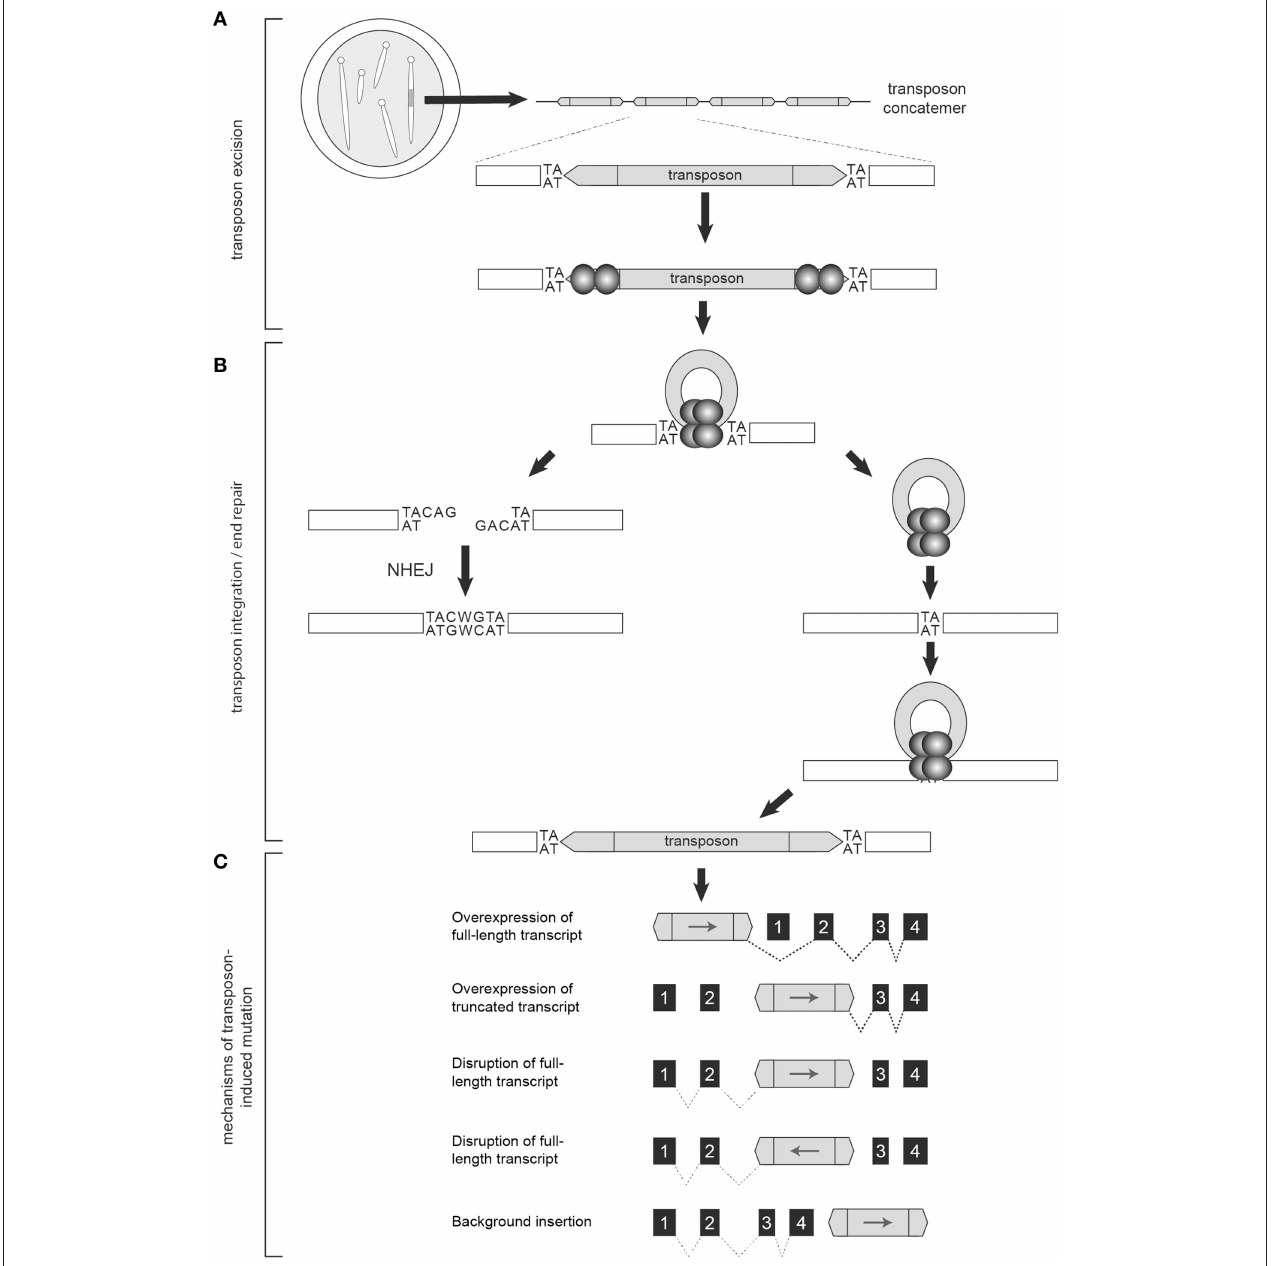
FIGURE 2 | The Sleeping Beauty System is designed to disrupt gene expression. Transgenic mice used in forward genetic SB screens harbor a transposon concatemer in one of their chromosomes (A) . Both ends of the transposon contain recognition sites that are necessary for transposon activation by the transposase (represented by the spherical structures) (A) . Upon mobilization, the remaining DNA is preferentially repaired by non-homologous end joining (NHEJ) while the mobilized transposon integrates into a TA-dinucleotide site within the parent genome (B) . Depending on location and orientation of insertion, the gene trap components of the transposon are capable of altering transcription to either increase or disrupt gene expression, resulting in oncogenic activation, or tumor suppressor disruption, respectively (C) .